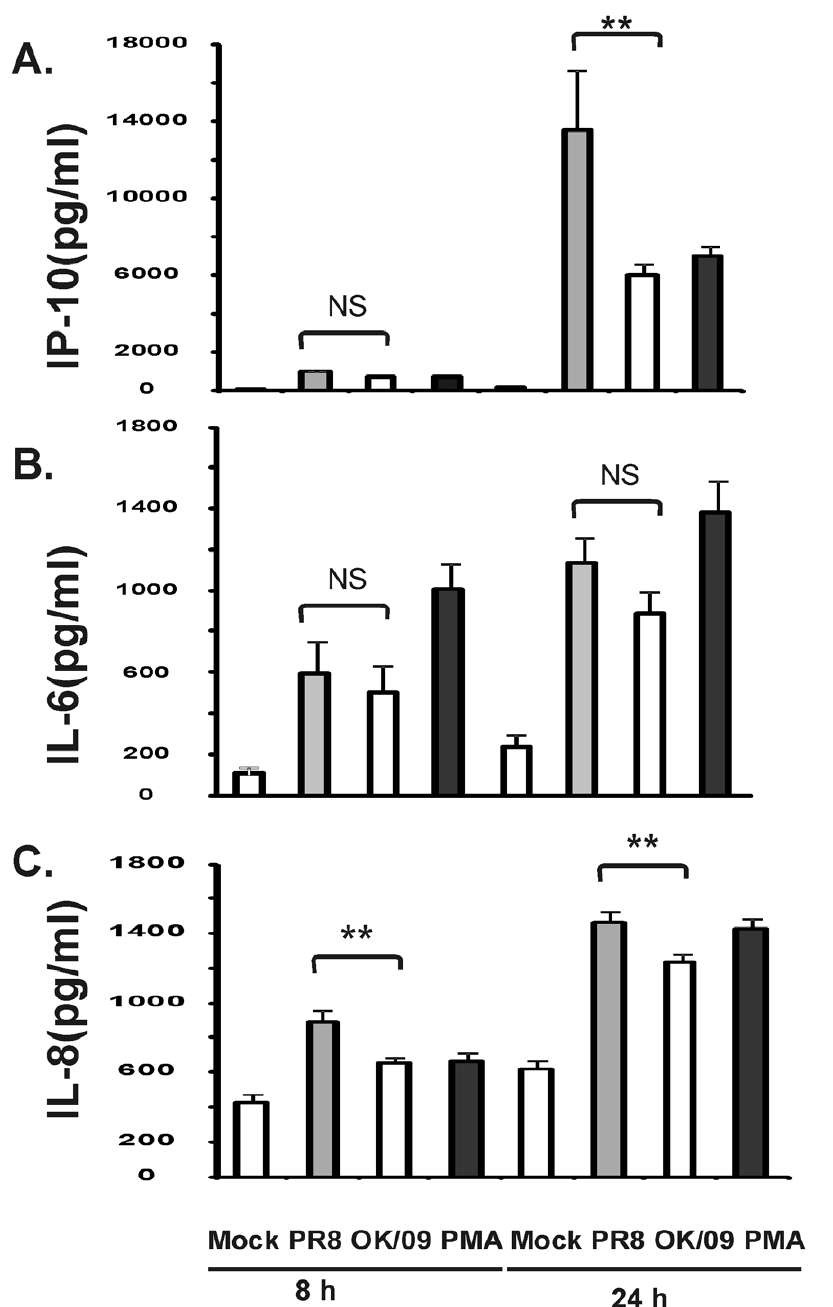
Figure 5. Pandemic OK/09 induces a diminished antiviral but not proinflammatory cytokine protein response as PR8 in human lung. For each data point, multiple lung slices were exposed to 6 6 10 6 PFU/ml of influenza virus PR8 and OK/09 and allowed to incubate at 37 u C, 5% CO 2 for the indicated periods. Virus diluent was used as a negative control, and PMA (100 ng/ml) was used as a positive control. Chemokine and cytokine protein levels were determined by ELISA on lung slice supernatants. Data are expressed as the means 6 SEM from three separate lung slice donor experiments. Statistical significance was determined by ANOVA. Means were compared to data from the negative control group.